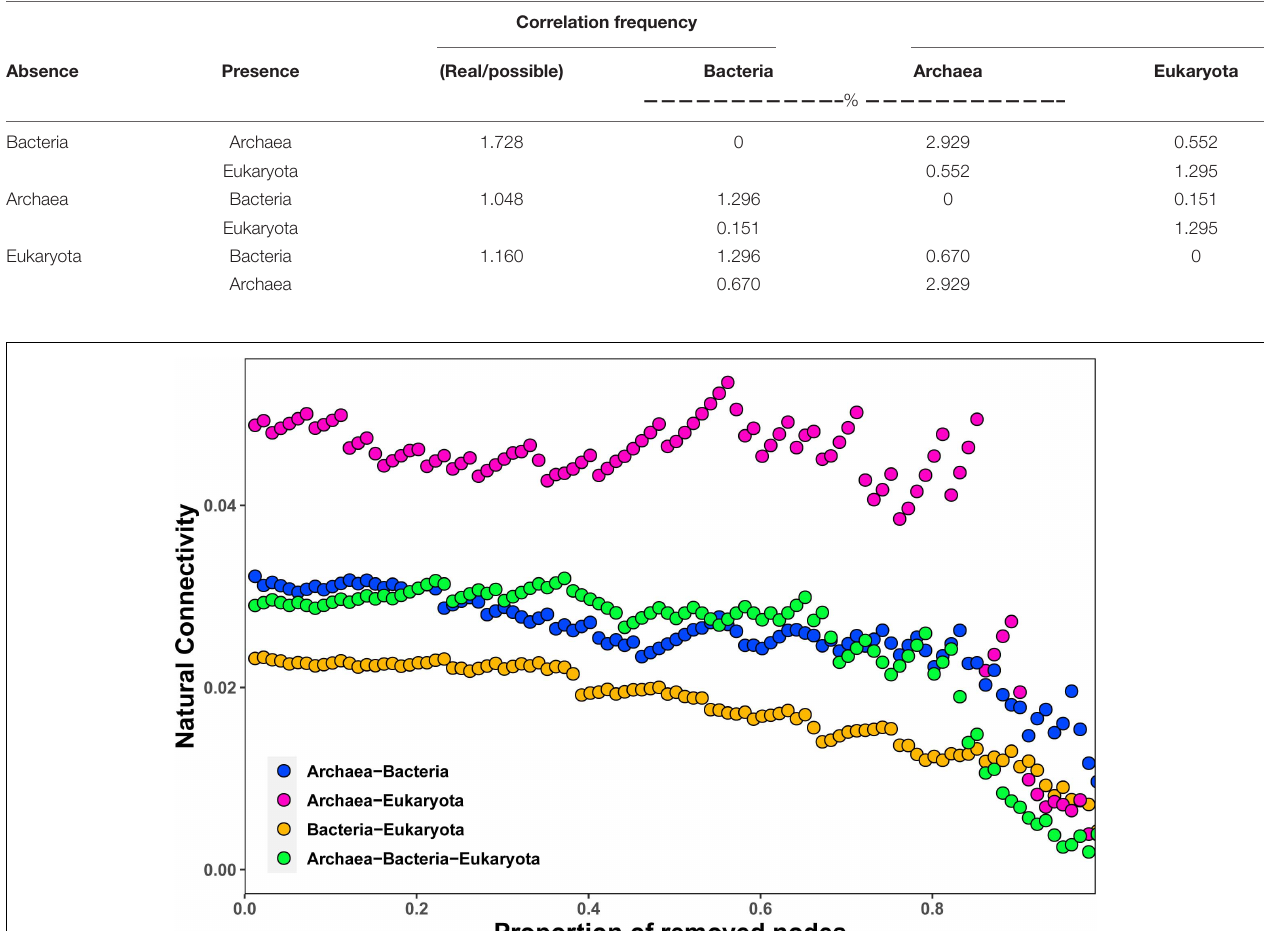
TABLE 3 | The correlation frequency (no. of real links/no. of possible links) between the groups of bacteria, archaea, and eukaryota based on an analysis of their absence and presence in the alpine meadow’s soils of the Qilian Mountains.